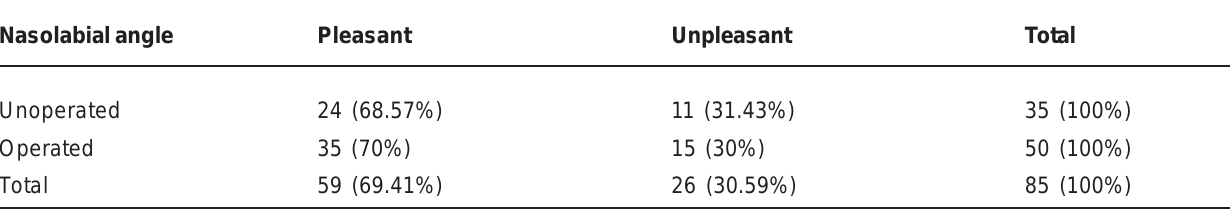
x 2 = 0.02; p = 0.888 non